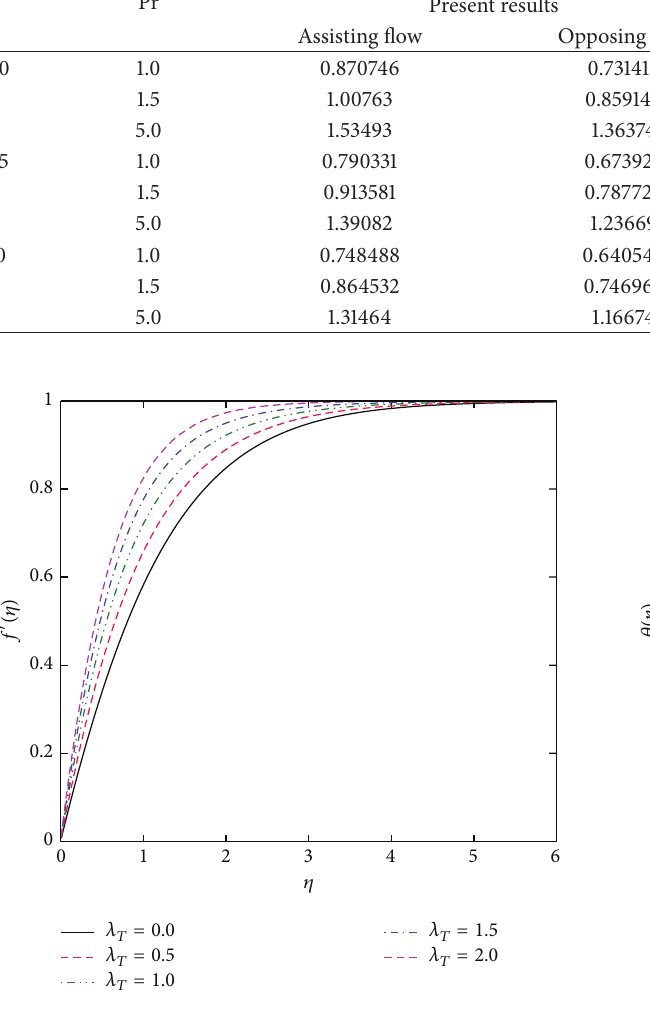
Figure8:Theeffectof 𝜆 𝑇 onvelocityprofilewhen 𝑘 1 = 0.6 ,Pr = 1.0 , and 𝑚 = 0.5 .